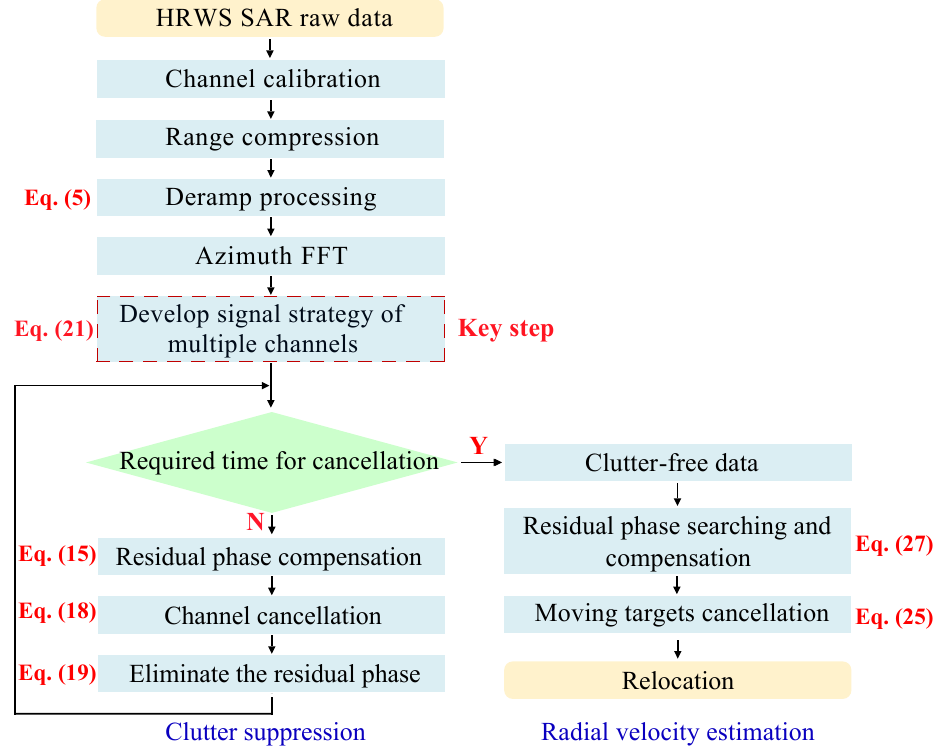
Figure 7. The flowchart of the GMTI in a multichannel HRWS SAR systems with the proposed multilayer channel-cancellation and radial velocity estimation